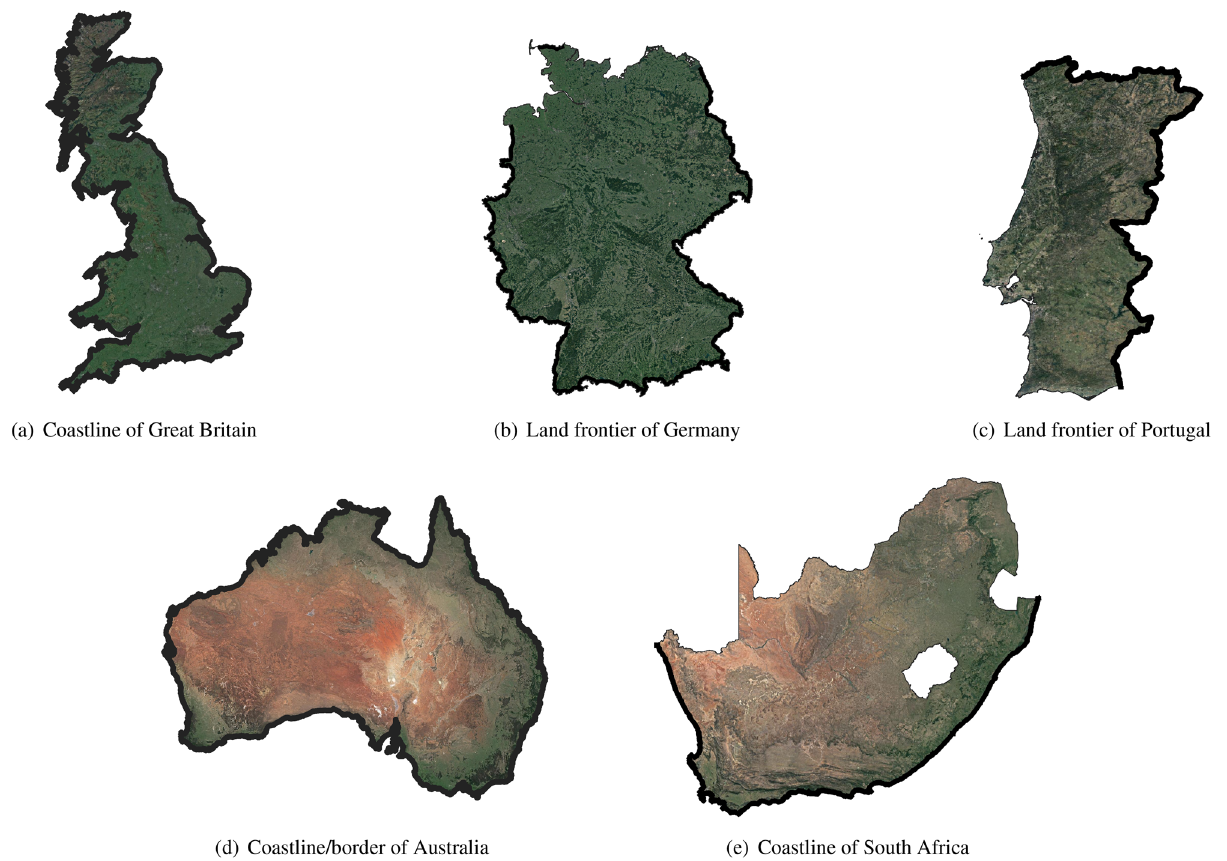
Figure 2. Some coastlines and borders created using QGIS, Pi-version (available at https:// qgis. org/ downl oads/). S.